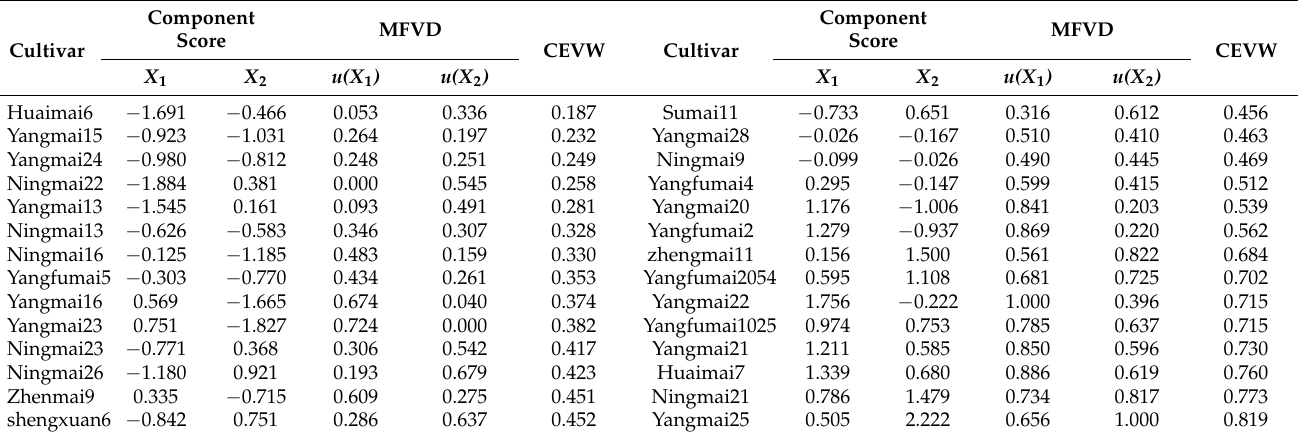
Table 6. Comprehensive evaluation value of the waterlogging tolerance (CEVW) of different cultivars and their calculations.